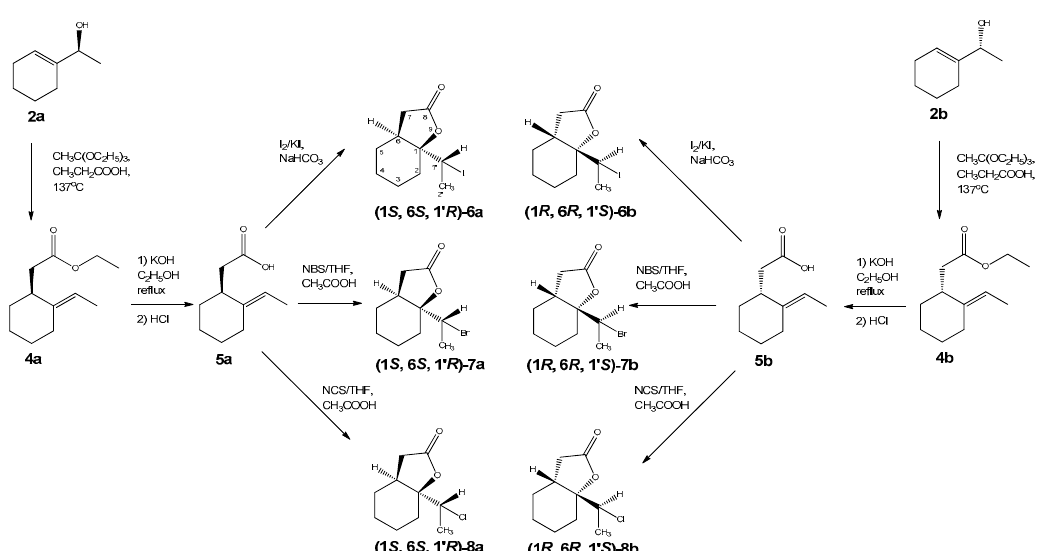
Scheme 3. Synthesis of enantiomeric pairs of halolactones 6 , 7 , 8 from ( S